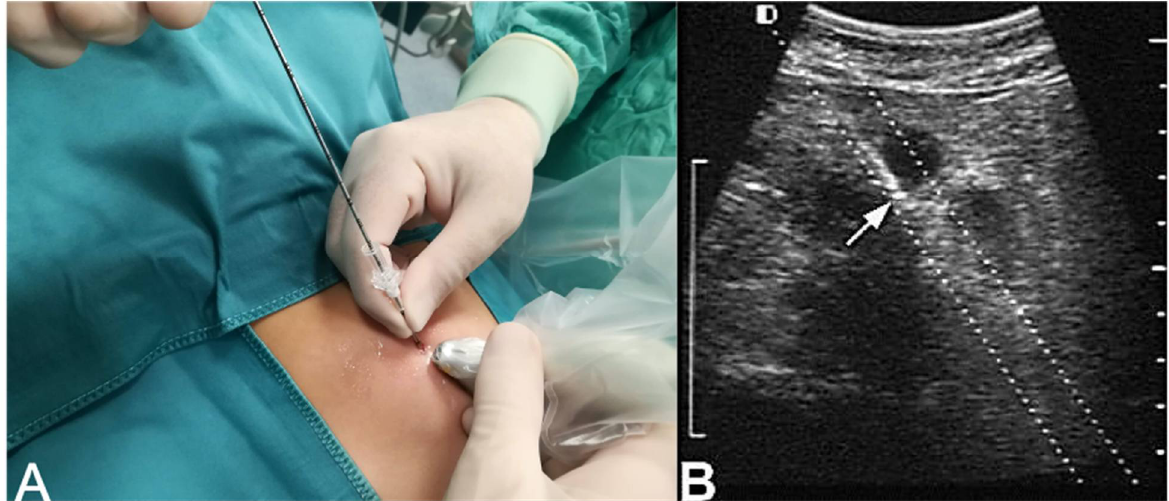
Figure 1. ( A ). Ultrasound scan of a large adrenal tumor. ( B ). Ultrasound-guided core needle biopsy (the arrow shows the tip of the needle within the adrenal gland).